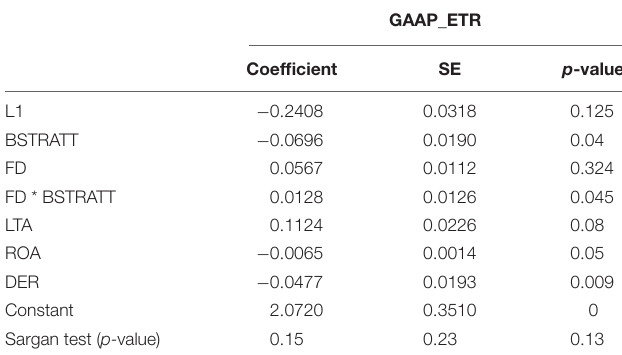
TABLE 3 | The moderating role of female directors on